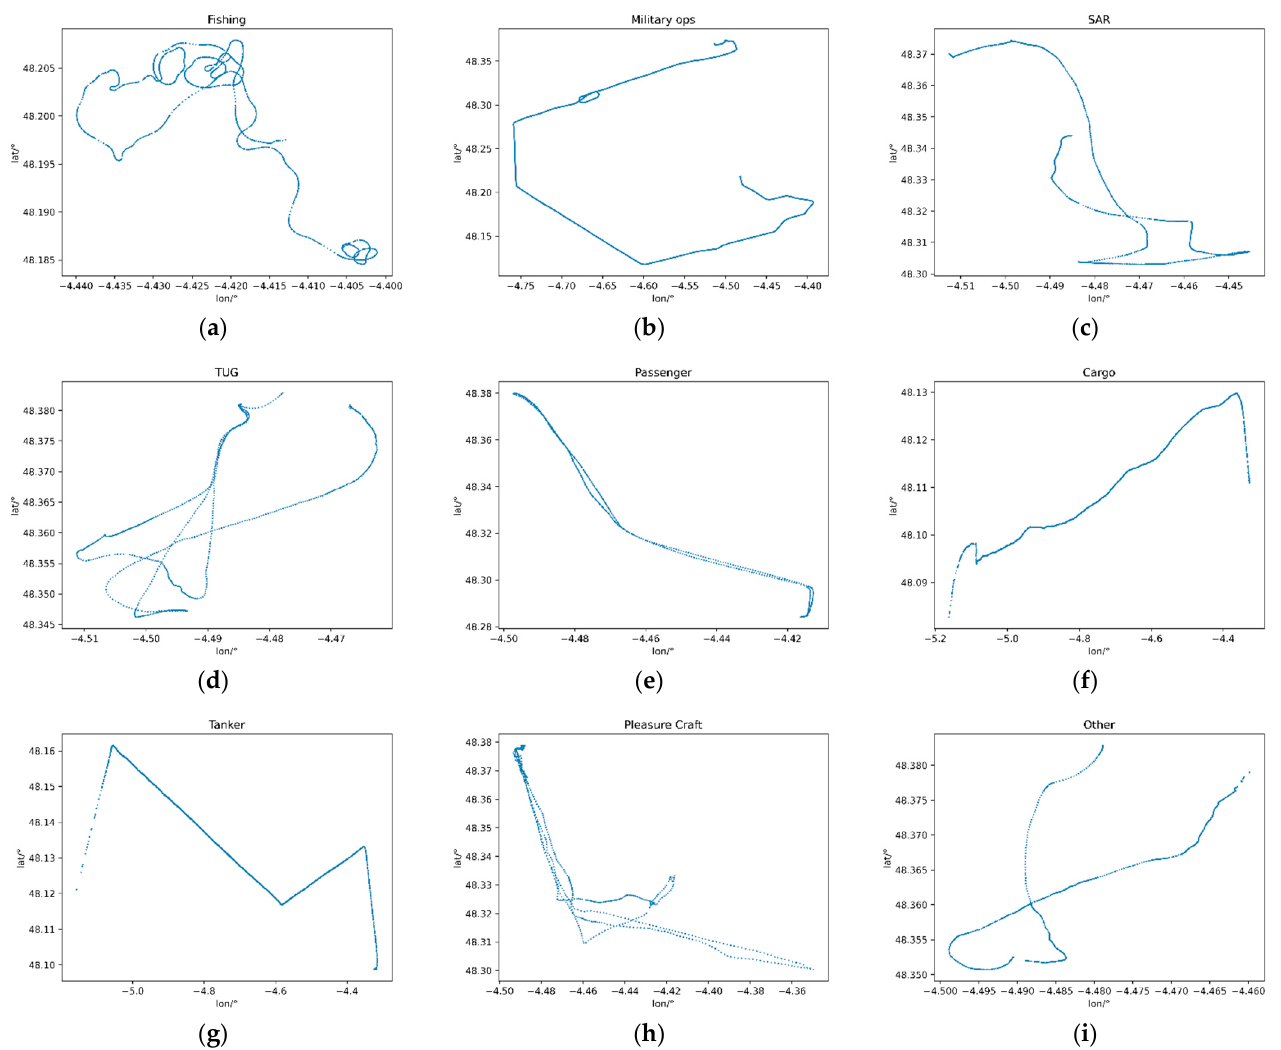
Figure 4. Examples of tracks of different ship types. ( a ) Fishing, ( b ) Military ops, ( c ) SAR, ( d ) TUG, ( e ) Passenger, ( f ) Cargo, ( g ) Tanker, ( h ) Pleasure Craft and ( i ) Other.